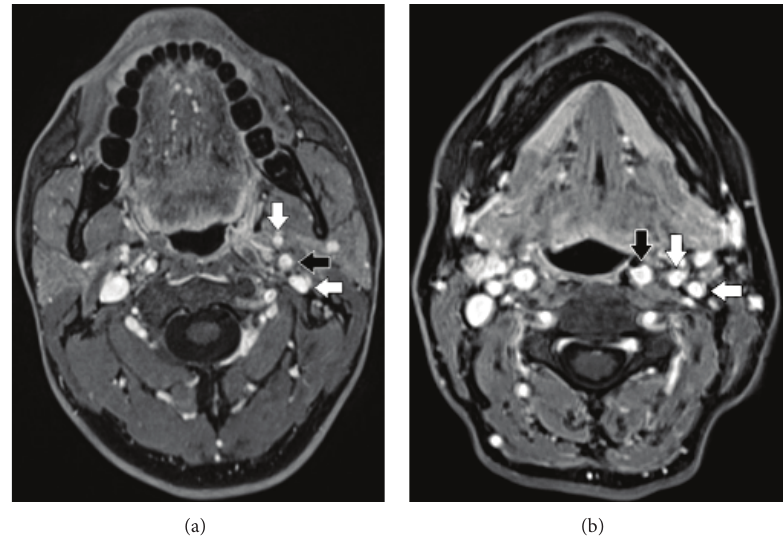
Figure 5: Patient 1 and patient 2, respectively: T1 weighted enhanced MRI scan. The internal carotid artery (black arrow), the external carotid artery (vertical white arrow), and the internal jugular vein (horizontal white arrow) are replaced in their original position with no evidence of